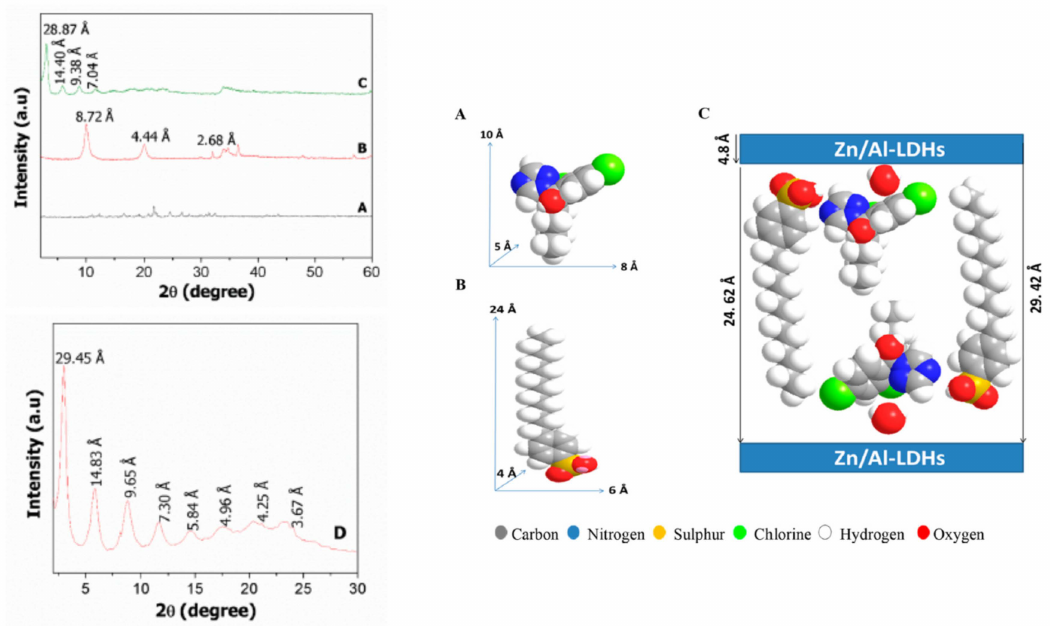
Figure 5. XRD patterns of free hexaconazole (A), Zn/Al-LDH (B), and hexaconazole-intercalated Zn/Al-LDH (the nanofungi- cide) (C), and the slow scan with a dwell time of 0.5 ◦ /min (D) showing details of the eight harmonics, and from them the average value of the interlamellar (nxd) was calculated to be 29.42 Å (left figure) and the 3D structure of hexaconazole ( A ), sodium dodecylbenzenesulfonate ( B ) and plausible arrangement of hexaconazole and sodium dodecylbenzenesulfonate in the intergalleries of HZALDH nanocomposite ( C ) (right figure)